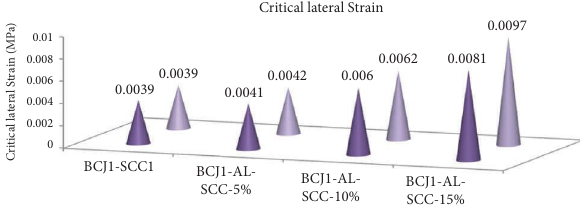
Figure 14: Ultimate lateral micro-strain vs. BCJ specimens.